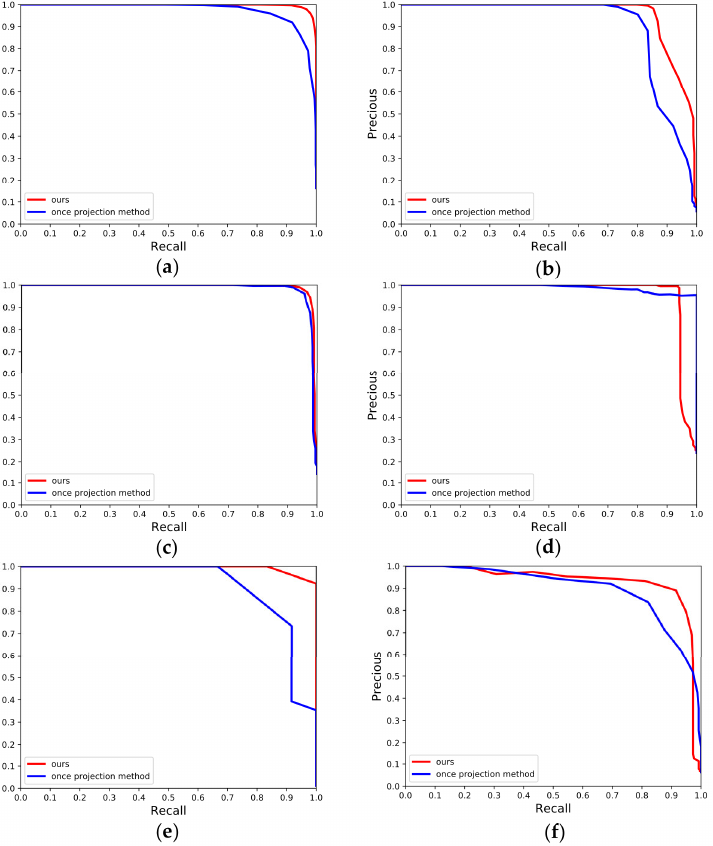
Figure 17. P-R curves over the dataset KITTI in ablation experiment. ( a ) KITTI-00; ( b ) KITTI-02; ( c ) KITTI-05; ( d ) KITTI-06; ( e ) KITTI-07; ( f ) KITTI-08.